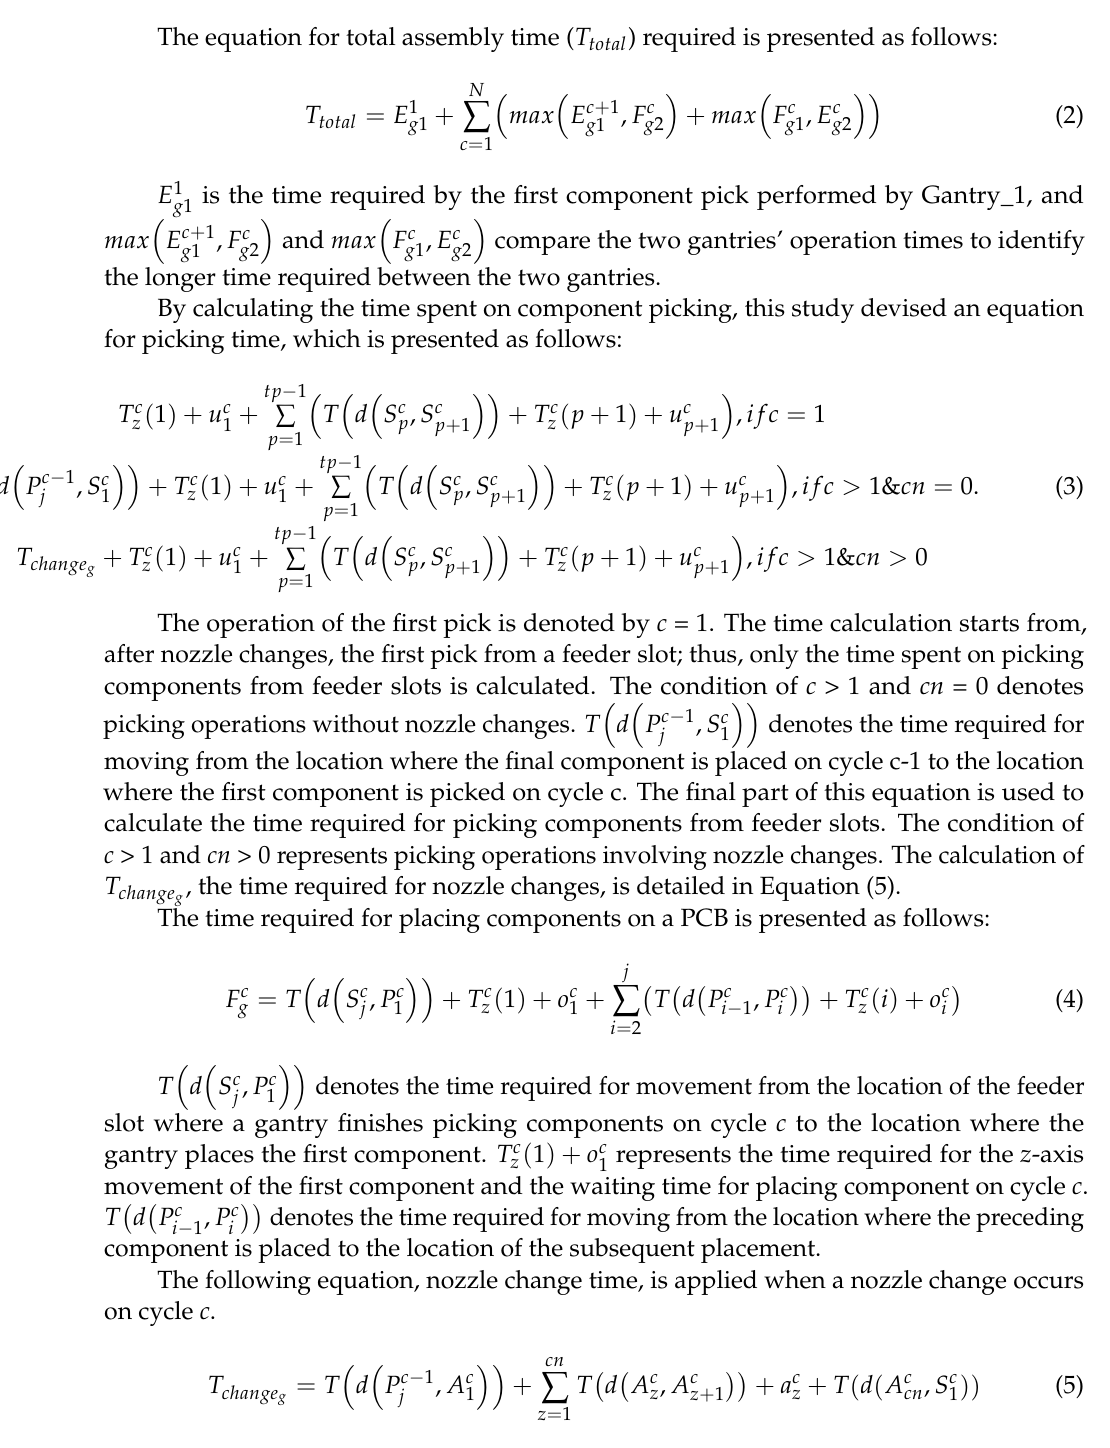
Figure 4. Alternating operations of the two gantries.